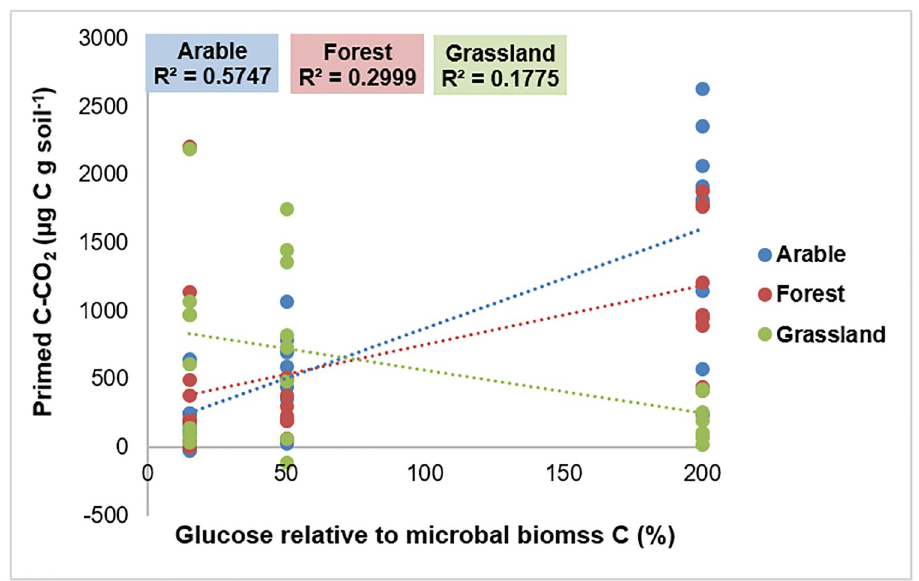
Fig 3. Regression analysis for the amount of added C-glucose expressed as % of microbial biomass (15%, 50% and 200%) versus primed C-CO 2 . Treatments are grouped together according to the ecosystems from which the soils were obtained.